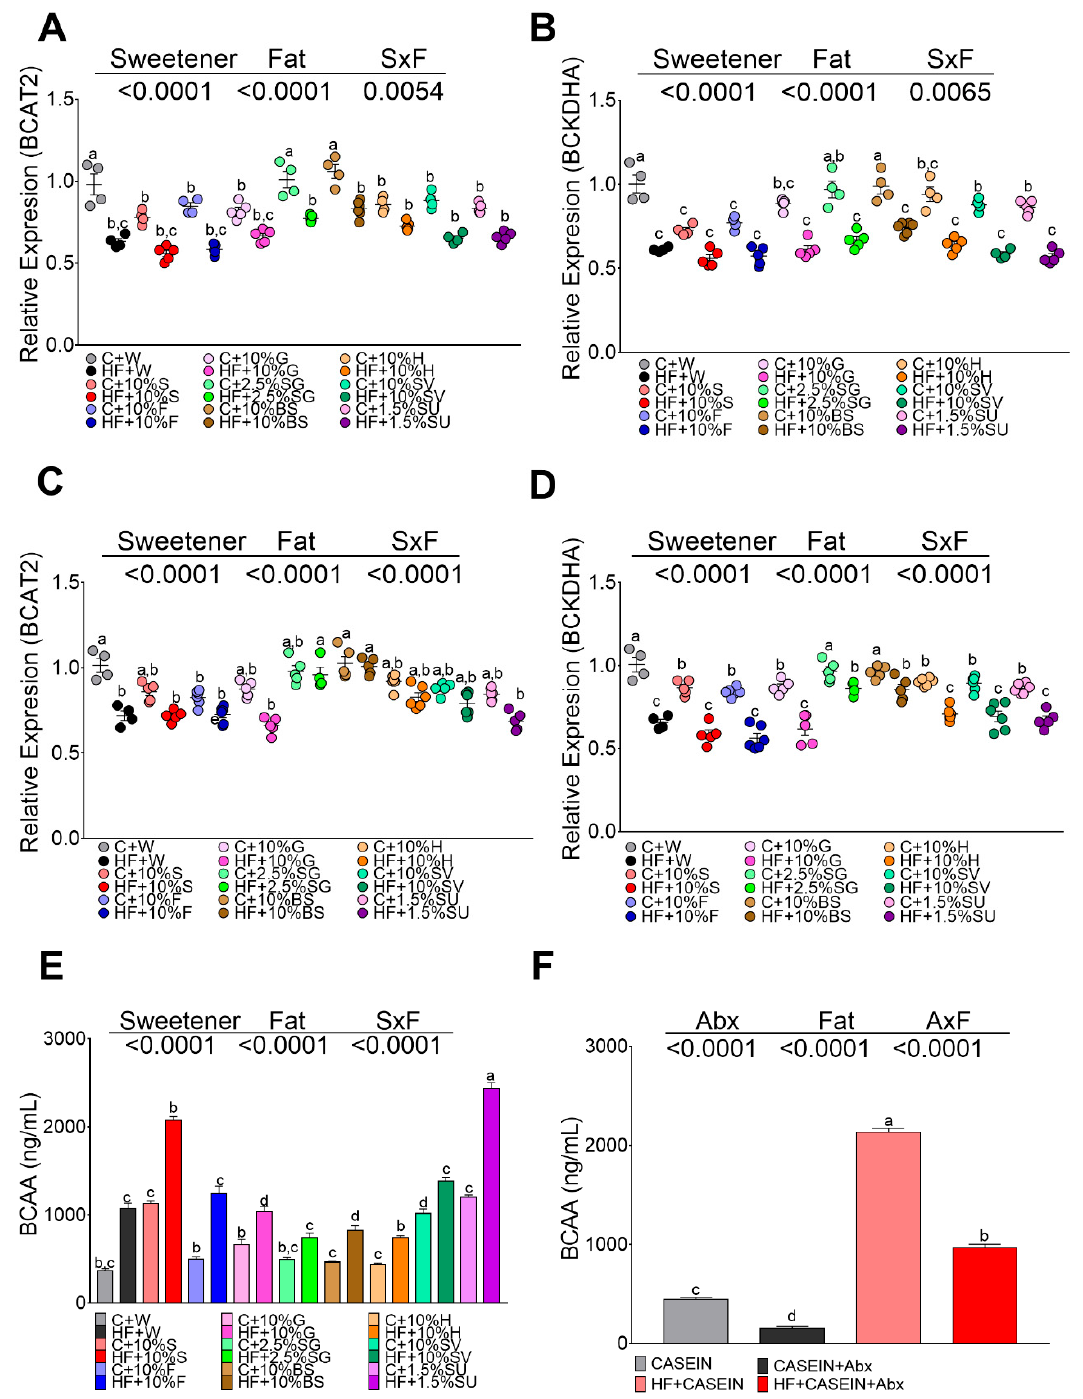
Figure 6. mRNA abundance of amino acid catabolizing enzymes in white adipose tissue (WAT) and brown adipose tissue (BAT), and circulating branched chain amino acids (BCAA) in rats fed different sweeteners with and without high fat diet. mRNA abundance of branched chain aminotransferase-2 (BCAT2) ( A ) and branched chain alpha keto acid dehydrogenase (BCKDH) ( B ) in WAT and BAT ( C, D ). Serum BCAA (valine, isoleucine, leucine) ( E ). Effect of antibiotics on serum BCAA, ( F ). The data are expressed as the mean ± SEM ( n = 6). Results were considered statistically significant at p < 0.05. Significant differences among groups groups are indicated by letters, where a > b > c > d > e.